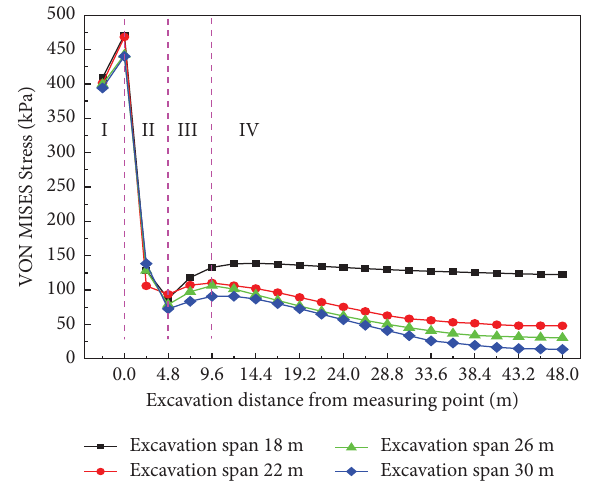
Figure 7: Curve of Von Mises stress in tunnel vault’s surrounding rocks with the advancing tunnel face under diferent excavation spans.